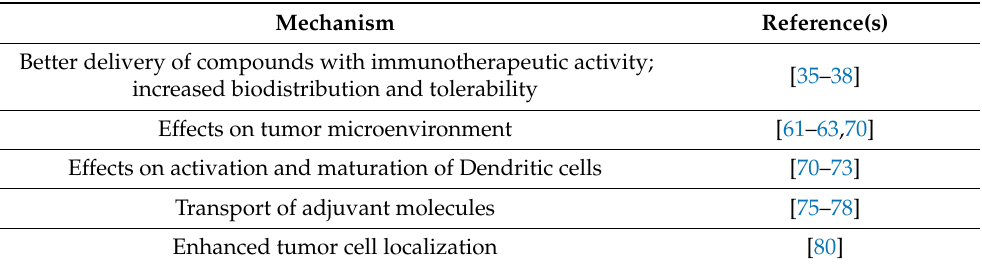
Table 1. Mechanisms through which nanoparticles can enhance the efficacy of immunotherapy (www.ClinicalTrials.gov, accessed on 5 September